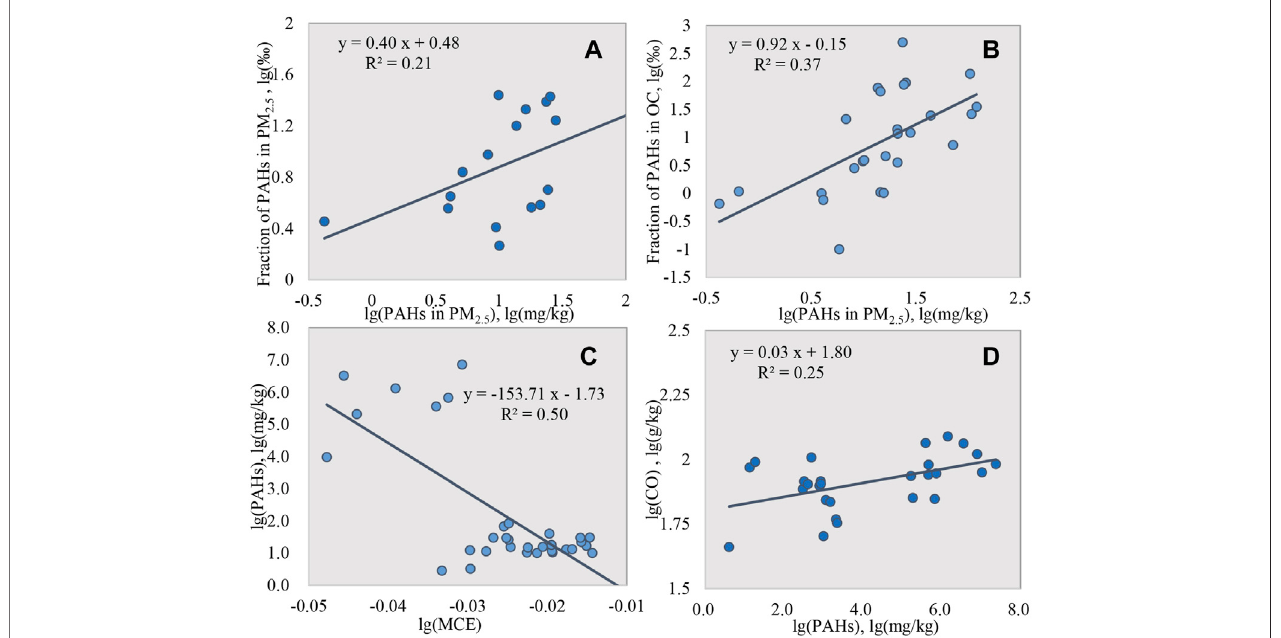
FIGURE 3 | Correlations between PAH EFs and other EFs (data were log transformed). (A) Correlations between EFs of particulate phase PAHs (EF particulate PAHs ) and the fraction of EF particulate PAHs in PM 2.5 ; (B) Correlations between EF particulate PAHs and the fraction of EF particulate PAHs in OC; (C) Correlations between PAH EFs and MCE; (D) Correlations between EFs of PAHs and CO.